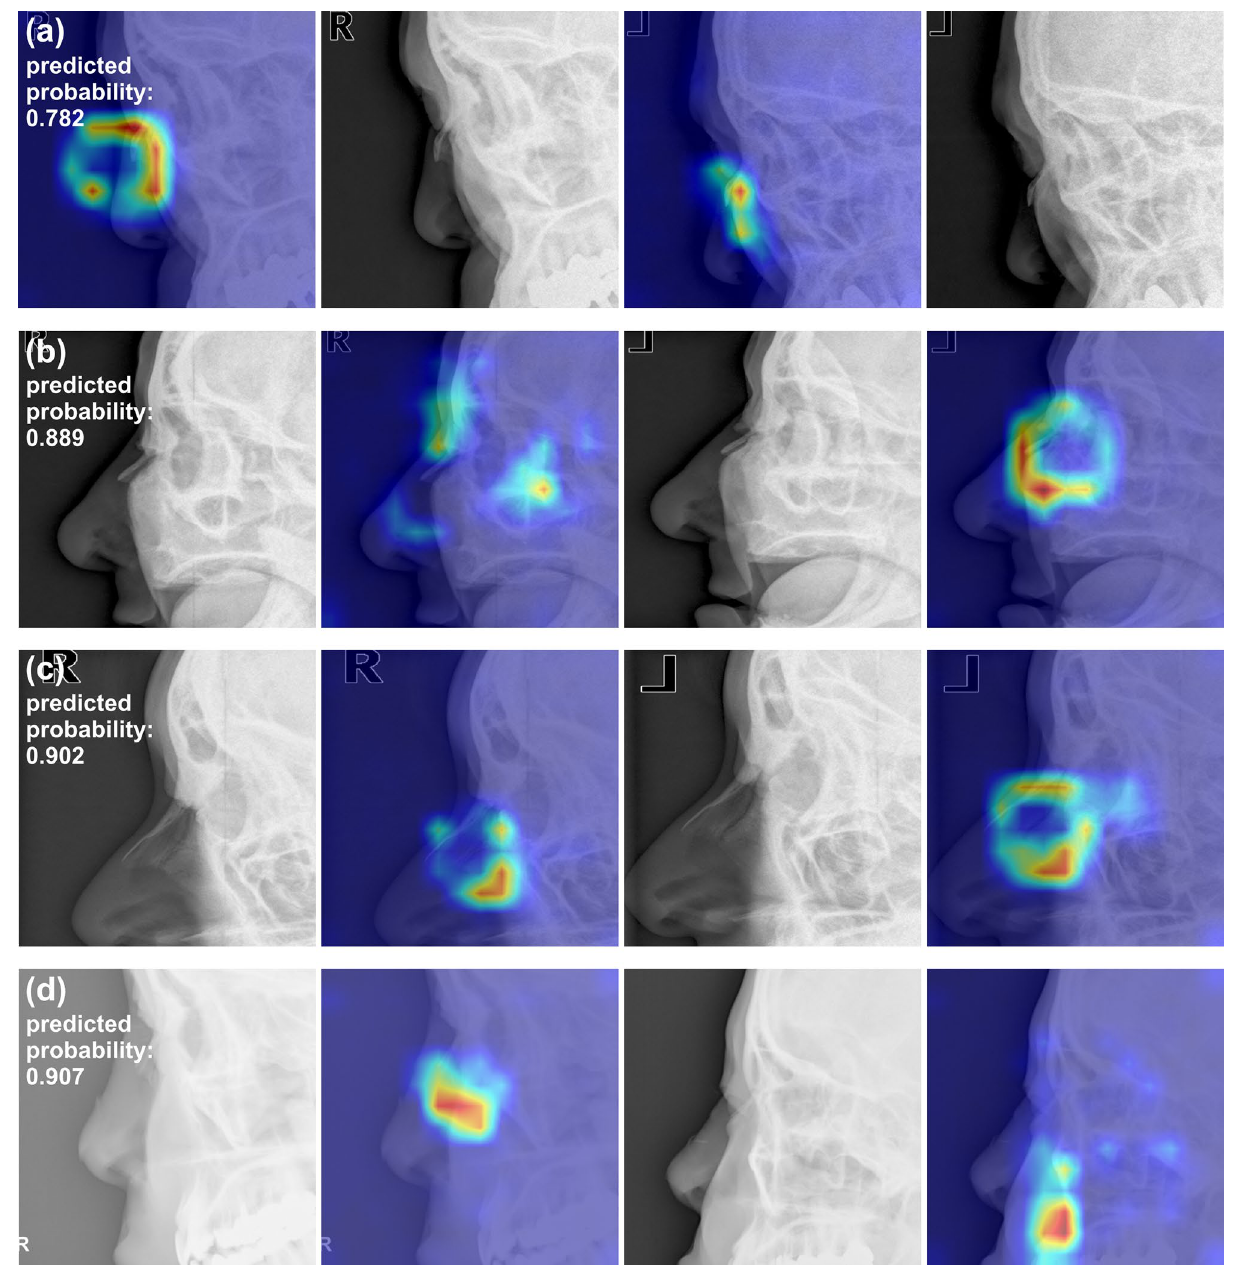
Figure 3. Examples of false positive images (normal nasal bone radiographs incorrectly diagnosed as fractures by the DL model). ( a ) The heatmap focuses on the angulated nasal bone in the left lateral view (right); ( b ) the heatmap focuses on nasal area narrowly separated from adjacent facial bones in the left lateral view (right); ( c ) the heatmap focuses on linear radiolucent line besides the nasal bone in the left lateral view (right); ( d ) the nasal bone is small and thin in the right lateral view (left) and faintly visible in the left lateral view (right). The predicted probabilities of fractures by the DL model are shown for each difference in nasal bones has been found between sexes 23 , and thus this difference would have not affected the outcome of this study. Finally, the study cohorts comprised an Asian population whose nasal bone anatomy may differ from that of other ethnicities. Thus, the developed DL model may not yield similar results for patients of different ethnicities. In conclusion, our CNN-based DL model demonstrated excellent performance comparable to that of expe- rienced radiologists in diagnosing nasal bone fractures on conventional radiographs. This promising finding could translate into DL applications that can be used as diagnostic assistance tools for patients with facial trauma.